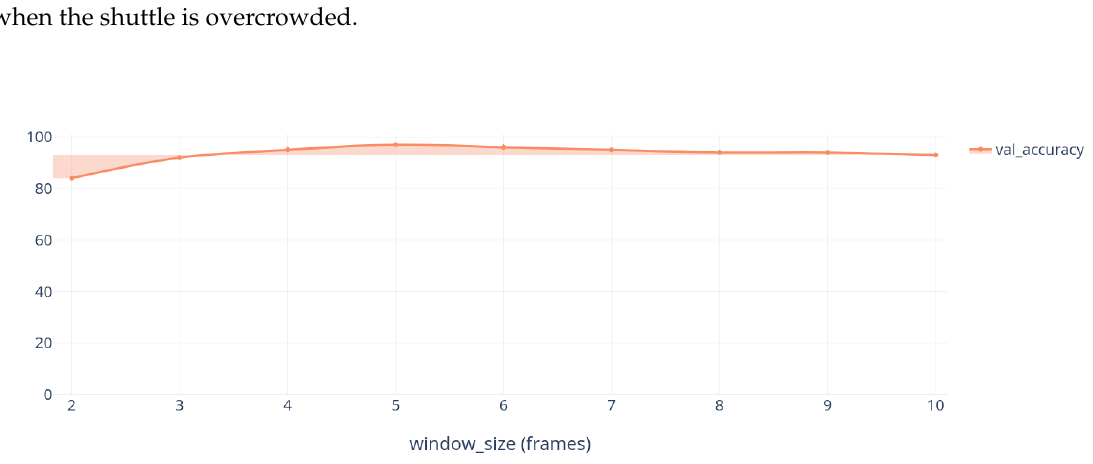
Figure 8. Performance evaluation across different buffer sizes. A buffer size of 5 frames achieved the best accuracy on the evaluation